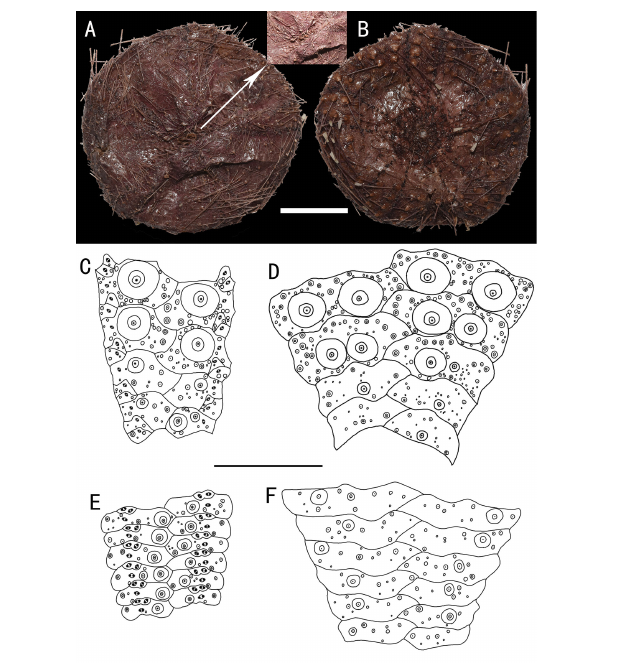
FIGURE 2 Hygrosoma involucrum sp. nov., holotype, MBM286941 (test diameter, 161 mm). (A) Aboral view. (B) Oral view. (C – F) Details of the coronal plates: (C) , oral ambulacra (D) , oral interambulacral (E) , aboral ambulacra (F) , aboral interambulacral. Scale bars , 50 mm (A, B) and 20 mm (C – F)